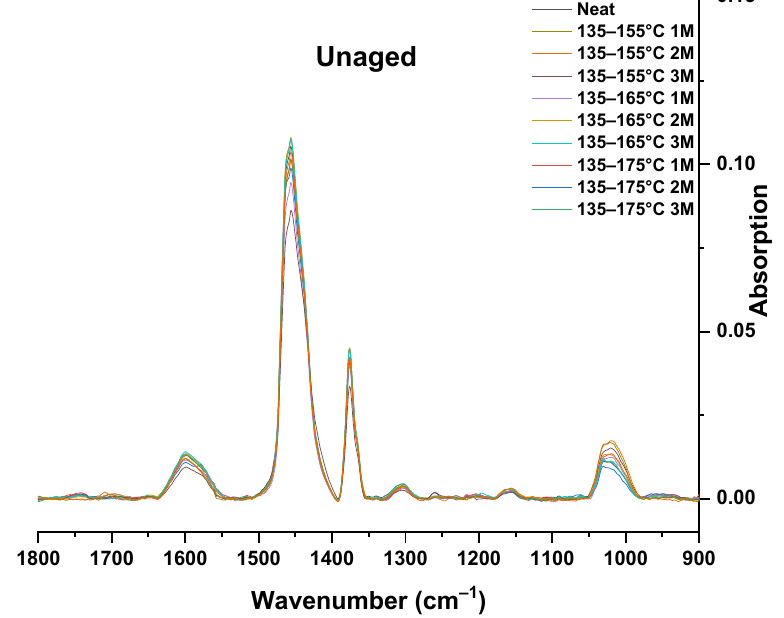
Figure 16. FTIR spectra of all samples at the unaged stage.